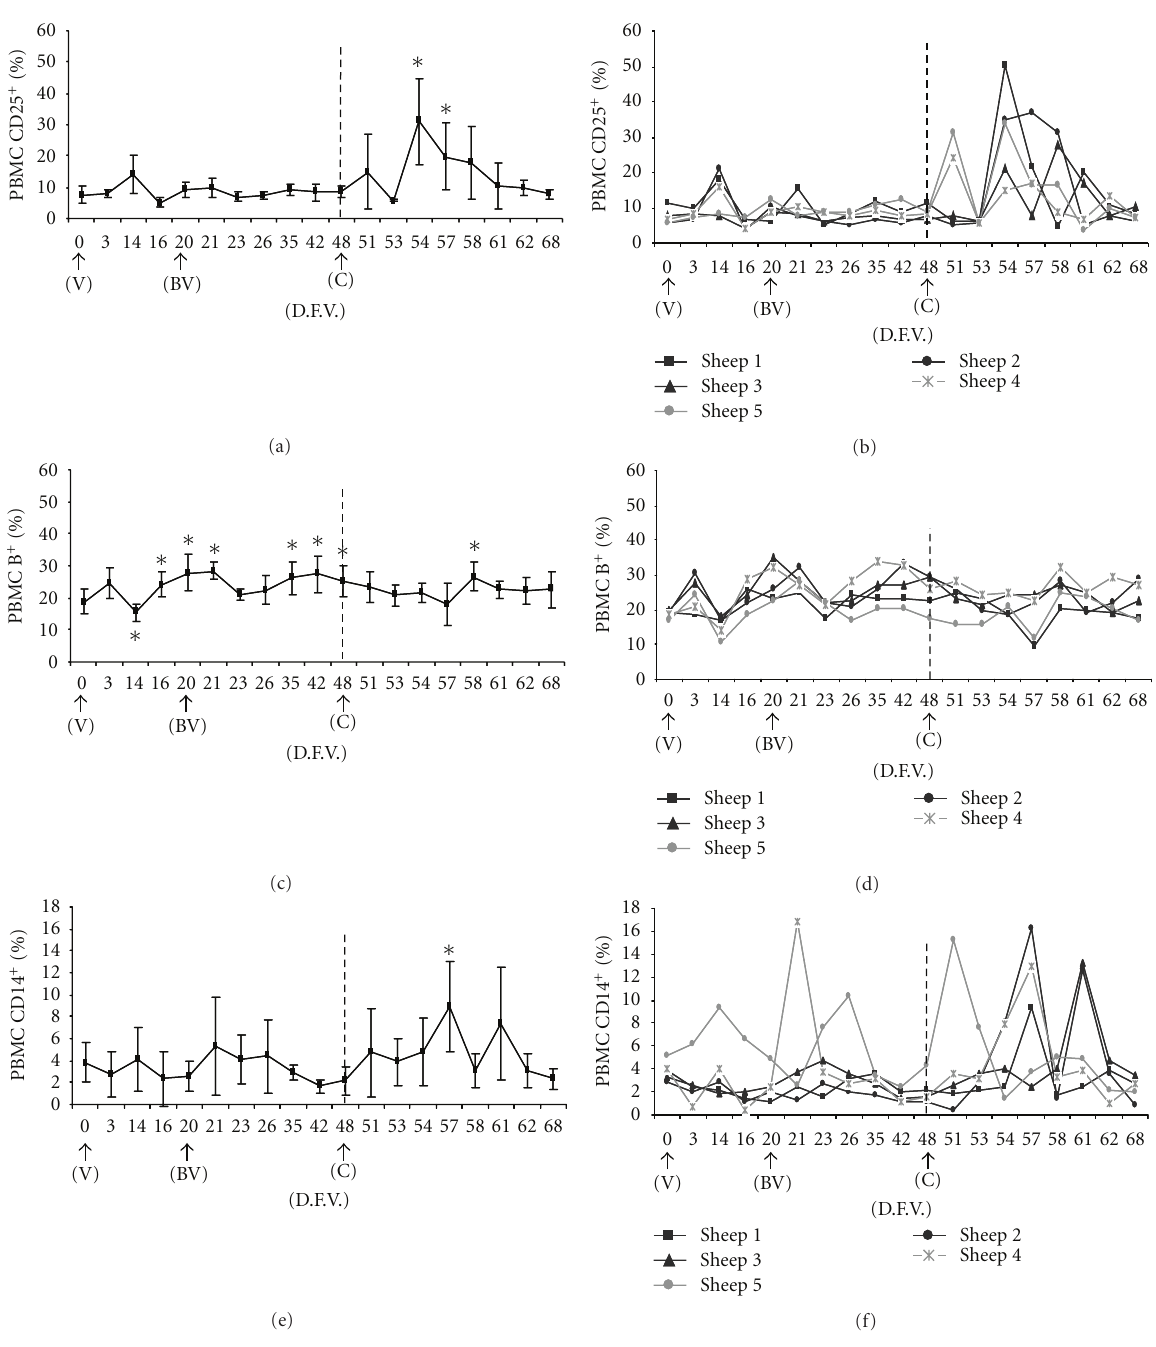
Figure 3: Mean percentages ( ± SD) and individual percentages of PBMC populations labeled by antibodies against CD25 + (a, b), B + cells (c, d), and CD14 + (e, f) throughout the experiment. ∗ is statistically significant di ff erence ( P ≤ 0.05) from the mean pre-vaccination value on day 0, based on ANOVA with the Huynh-Feldt correction. Abbreviations: V, day of first vaccination; DFV, day after first vaccination; BV, day of boost vaccination; C, day of